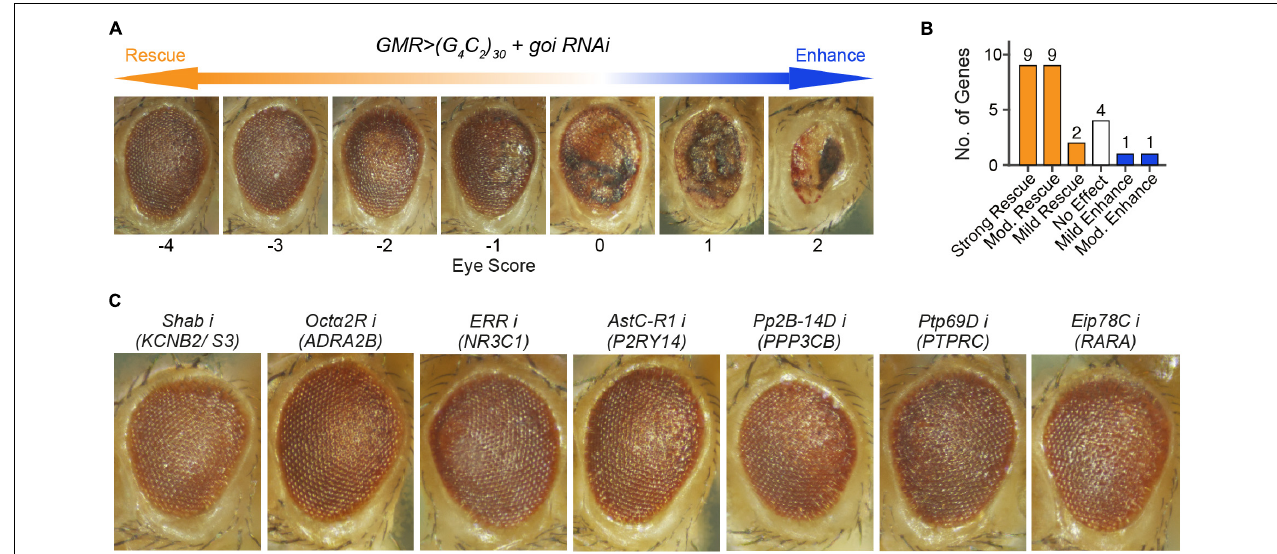
FIGURE 2 | Loss of seven unreported fly orthologs, corresponding to eight genes, strongly rescued (G 4 C 2 ) 30 -mediated neurodegeneration in a c9ALS Drosophila model. (A) A scale of magnitude of degeneration in fly eyes expressing (G 4 C 2 ) 30 scored from –4 to 2. The control flies (score 0), whose eyes expressing (G 4 C 2 ) 30 , exhibited eye degeneration, as indicated by necrotic patches, loss of ommatidia, depigmentation, and retinal collapse. The degree of eye degeneration rescue by RNAi of the gene of interest (goi) ranged from –4 to 2, where score –4 represented the strongest degree of rescue and score 2 stood for the highest degree of enhancement. (B) Number of genes whose loss gave rise to different degrees of modifications. Strong rescue stood for a score ≤ –3, moderate (mod.) rescue or enhance for a score ≤ –2 or ≥ 2, mild rescue or enhance for a score ≤ –1 or ≥ 1, and no effect for a score > –1 and < 1. For a gene with multiple fly orthologs, the score corresponding to the strongest modification of eye degeneration was used to represent the effect of suppressing the gene. (C) Fly eyes expressing (G 4 C 2 ) 30 with RNAi against (from left to right) Shab (fly ortholog of KCNB2 and KCNS3 ), Oct α 2R (fly ortholog of ADRA2B ), ERR (fly ortholog of NR3C1 ), AstC-R1 (fly ortholog of P2RY14 ), Pp2B-14D (fly ortholog of PPP3CB ), Ptp69D (fly ortholog of PTPRC ), and Eip78C (fly ortholog of RARA